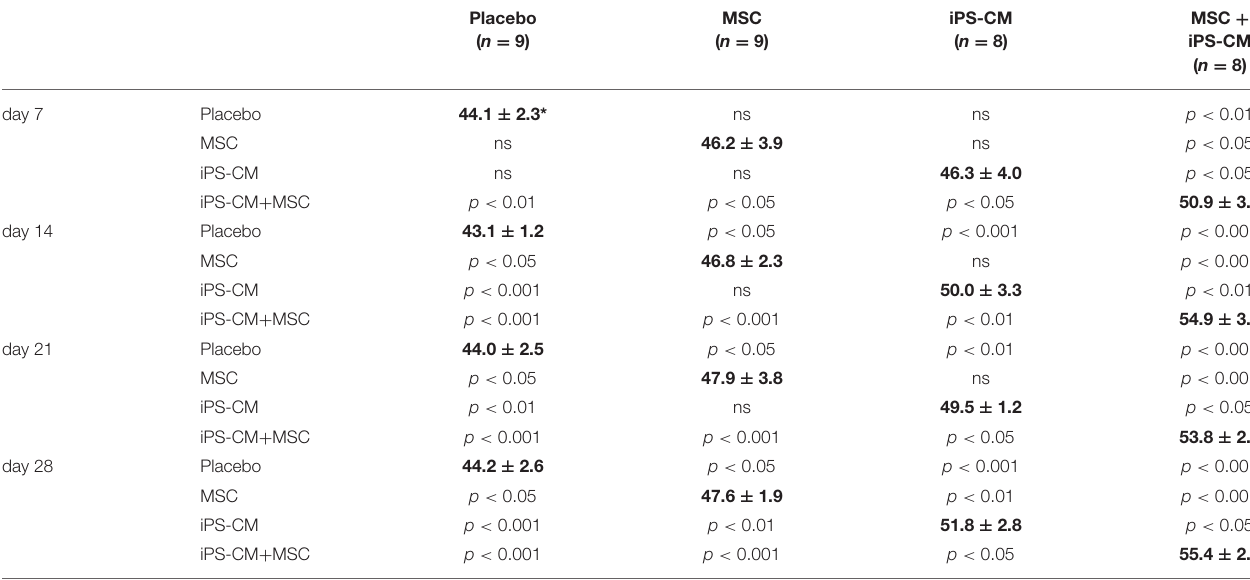
TABLE 1 | Statistical analysis of LVEF results from cardiac MRI measurements by ANOVA and post hoc Tukey-Kramer multi-group comparison tests.